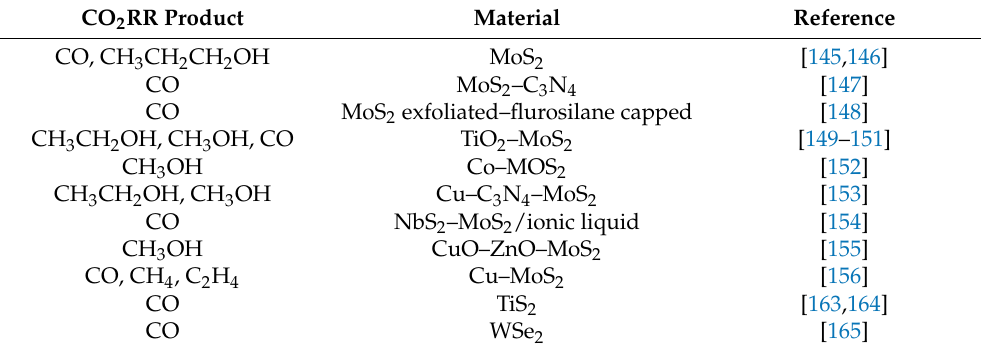
Table 1. Summary of products in the CO 2 RR using the various TMS-layered nanomaterials and their associated composite